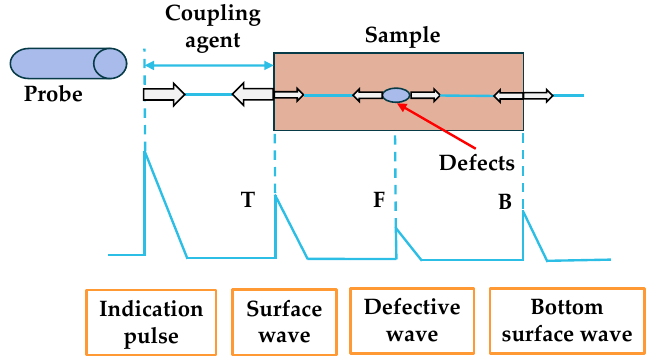
Figure 15. Principle diagram of the pulse-echo method.